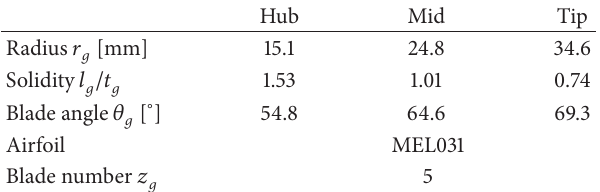
Table 2: Specifications of guide